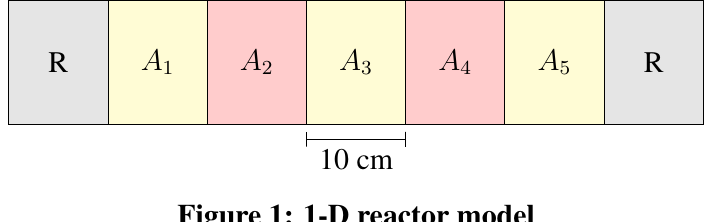
Figure 1: 1-D reactor